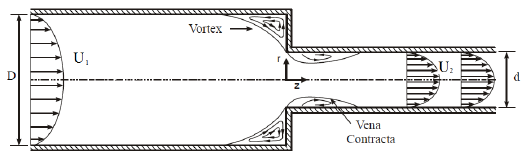
Figure 1. Schematic representation of problem definition for a sudden contraction. Adapted from [26].